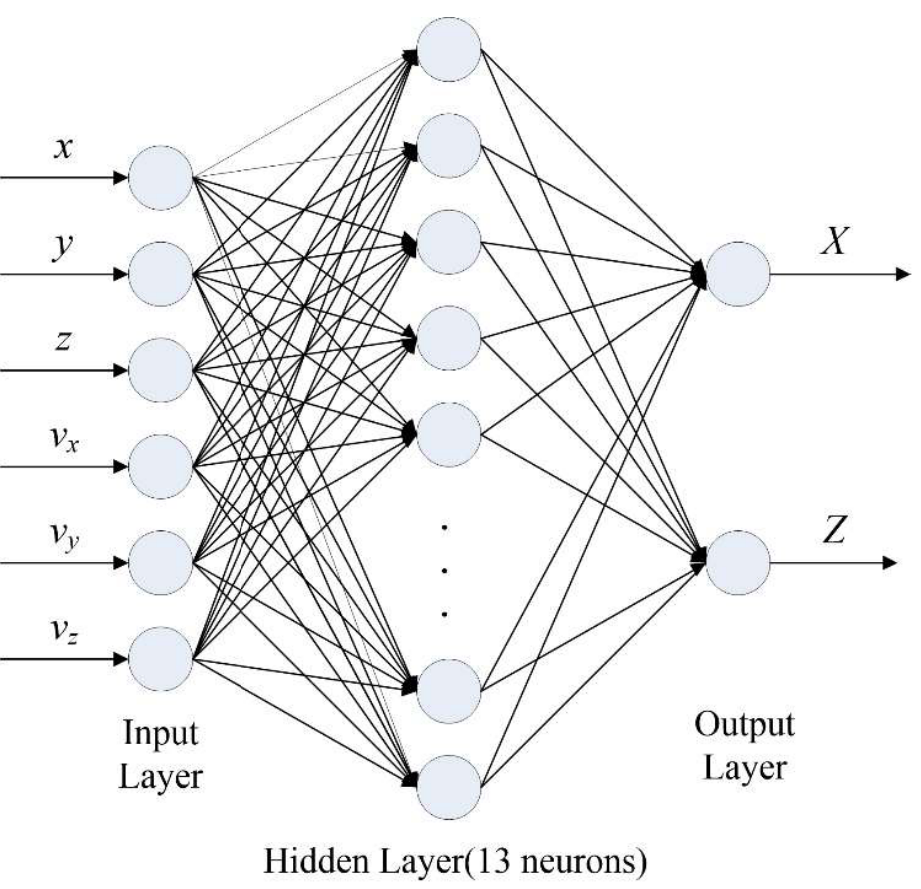
Figure 3. The deep learning PSP and classification.